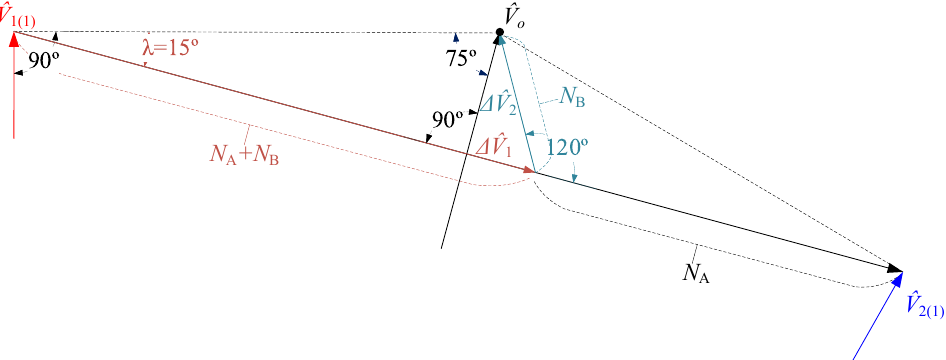
Figure 4. Details of geometric relationship between the output vector ˆ V o of the 12-pulse modular VSI and component vectors ˆ V 1 and ˆ V 2